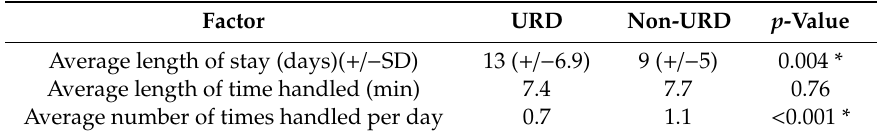
Table 2. Comparison of various average time variables from the Poisson regression model between cats that developed clinical signs of upper respiratory disease (URD) vs. those that did not develop URD signs. p -value < 0.05 considered significant. Significance identified with